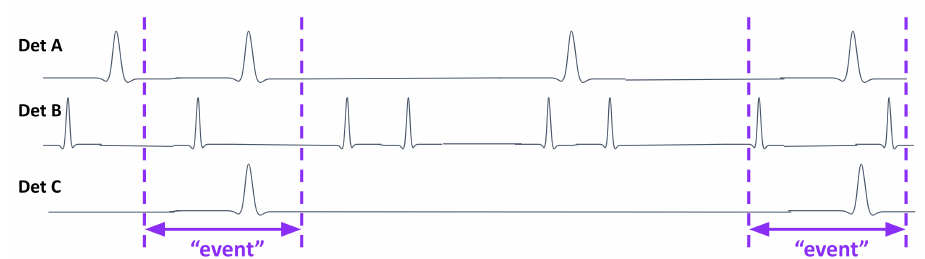
Figure 3. Traditional triggered systems record regions of time surrounding a possible interesting physics interaction as an “event”. This sketch illustrates this. For streaming mode, the concept of an “event” transitions into a time frame. See text for details.